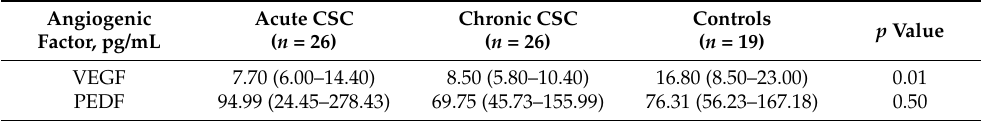
Figure 2. Box-and-whisker plot of plasma vascular endothelial growth factor (VEGF) levels in all patients with central serous chorioretinopathy (CSC) (acute and chronic) as well as controls ( p = 0.003). Table 3. Plasma levels of vascular endothelial growth factor (VEGF) and pigment-epithelium-derived factor (PEDF) in patients with acute central serous chorioretinopathy (CSC), patients with chronic CSC, and controls.